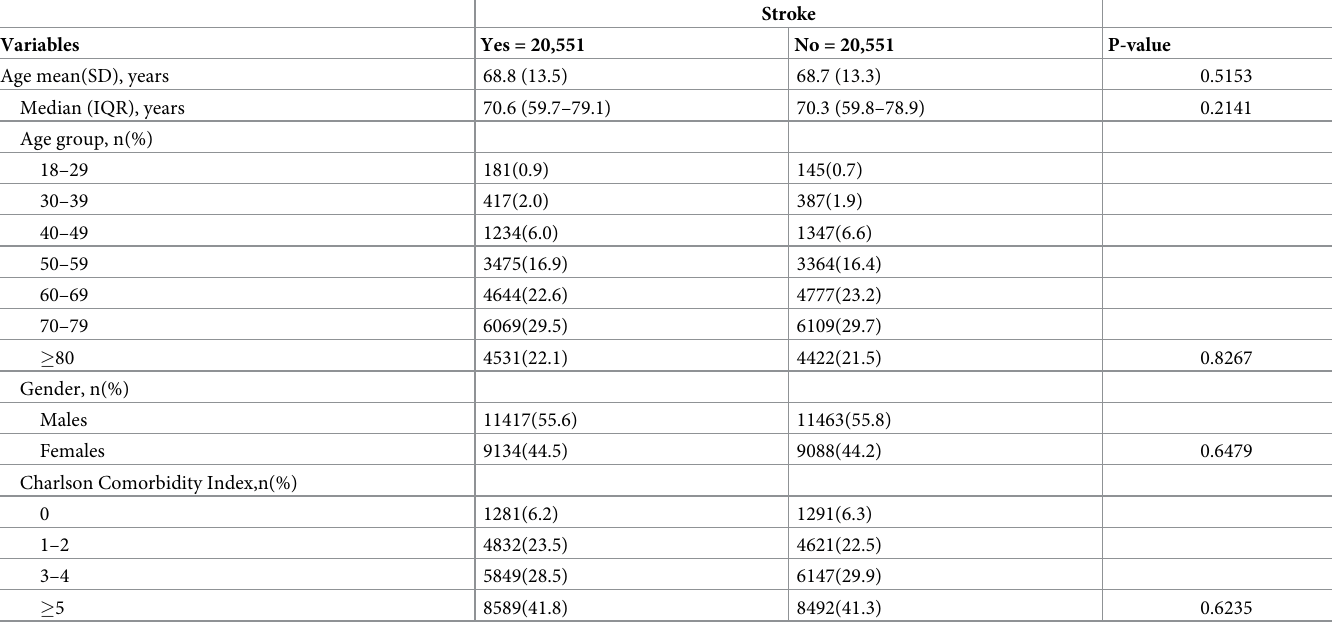
Table 1. Characteristics of subjects with stroke and matched